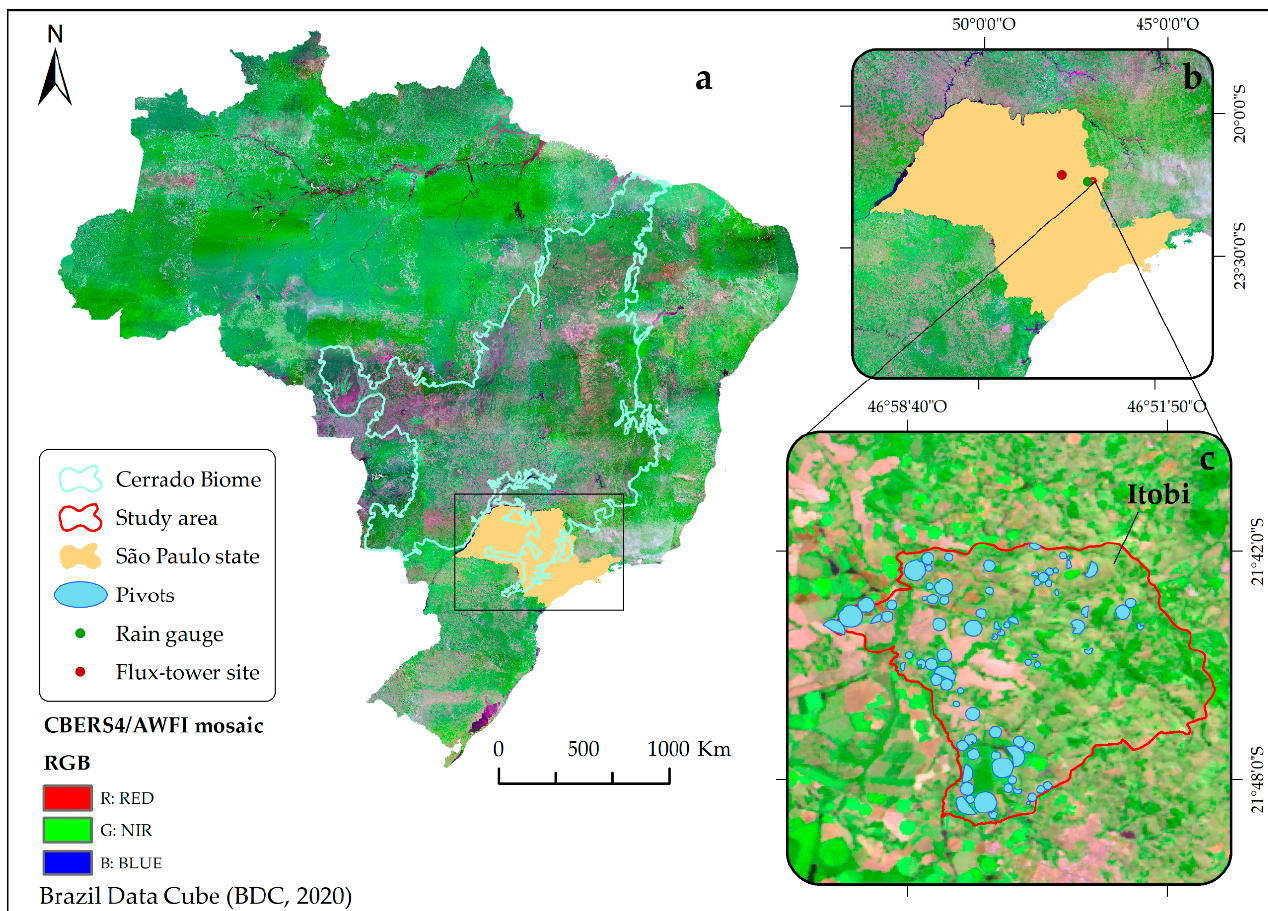
Figure 1 . ( a ) Study area located in the Brazilian Savanna highlighted in the center of Brazil’s map. The black rectangle indicates the state of São Paulo; ( b ) indicates the municipality of Itobi and rain gauge and flux-tower sites; ( c ) indicates the municipality of Itobi and the center pivots that were analyzed. The study area comprises the irrigation pole of Rio Pardo and Mogi Guaç ú , covering an area of 1,097,088 ha and an irrigated area of 129,287 ha. This irrigation pole has a total and effective potential of 232,575 ha and 65,989 ha, respectively, and is considered one of the poles with the greatest expansion perspective [1,2]. Center pivot irrigation is October. In the last two decades, the number of center pivots and total irrigated